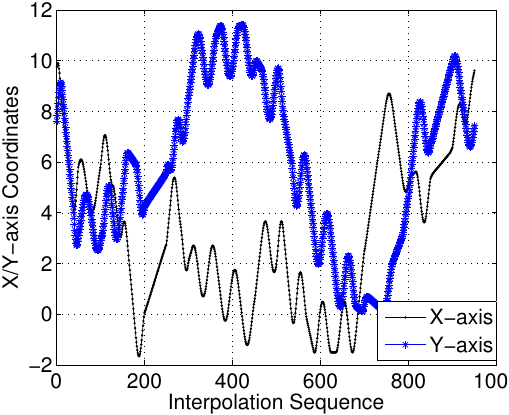
Figure 16. X / Y -axis of three-dimensional (3D) Dubins curves (case